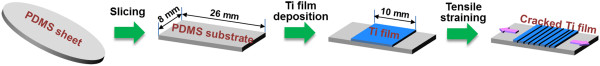
Schematic process to fabricate a cracked Ti film on a PDMS substrate. Step 1: preparation of a PDMS sheet, step 2: slicing of the PDMS sheet into 26 mm × 8 mm-sized samples, step 3: deposition of a Ti thin film on the PDMS substrate, and step 4: generation of cracks by mechanical stretching.